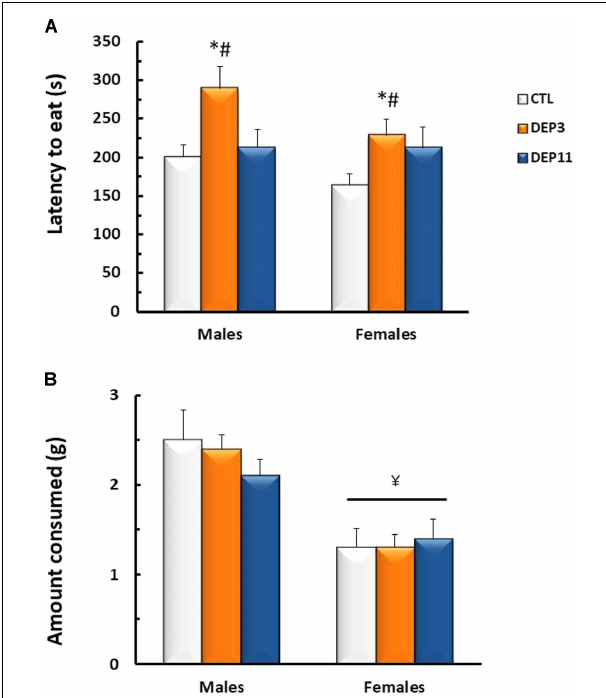
FIGURE 1 | Latency to the first bite in the chow pellet (A) and amount of chow consumed (B) in a 10 min session of novelty suppressed feeding test. Animals were maintained with their mothers (CTL), deprived on postnatal day (PND) 3 (DEP3) or on PND 11 (DEP11) and tested between PNDs 52 and 60. Data are presented as mean ± SEM of 9–10 animals/group/sex. ∗ – Different from CTL group; # – different from DEP11 group; (cid:85) – different from respective male group.